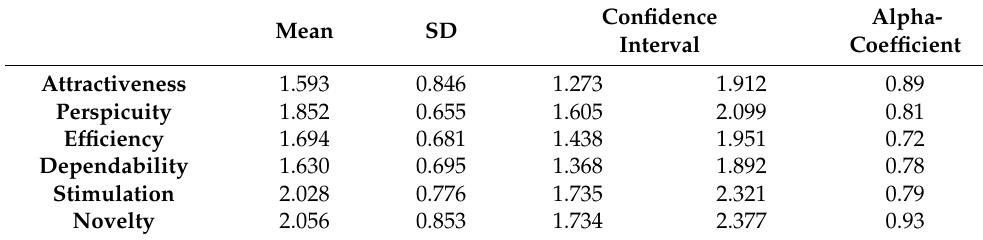
Table 6. Scores of the six UEQ scales. SD, standard deviation.